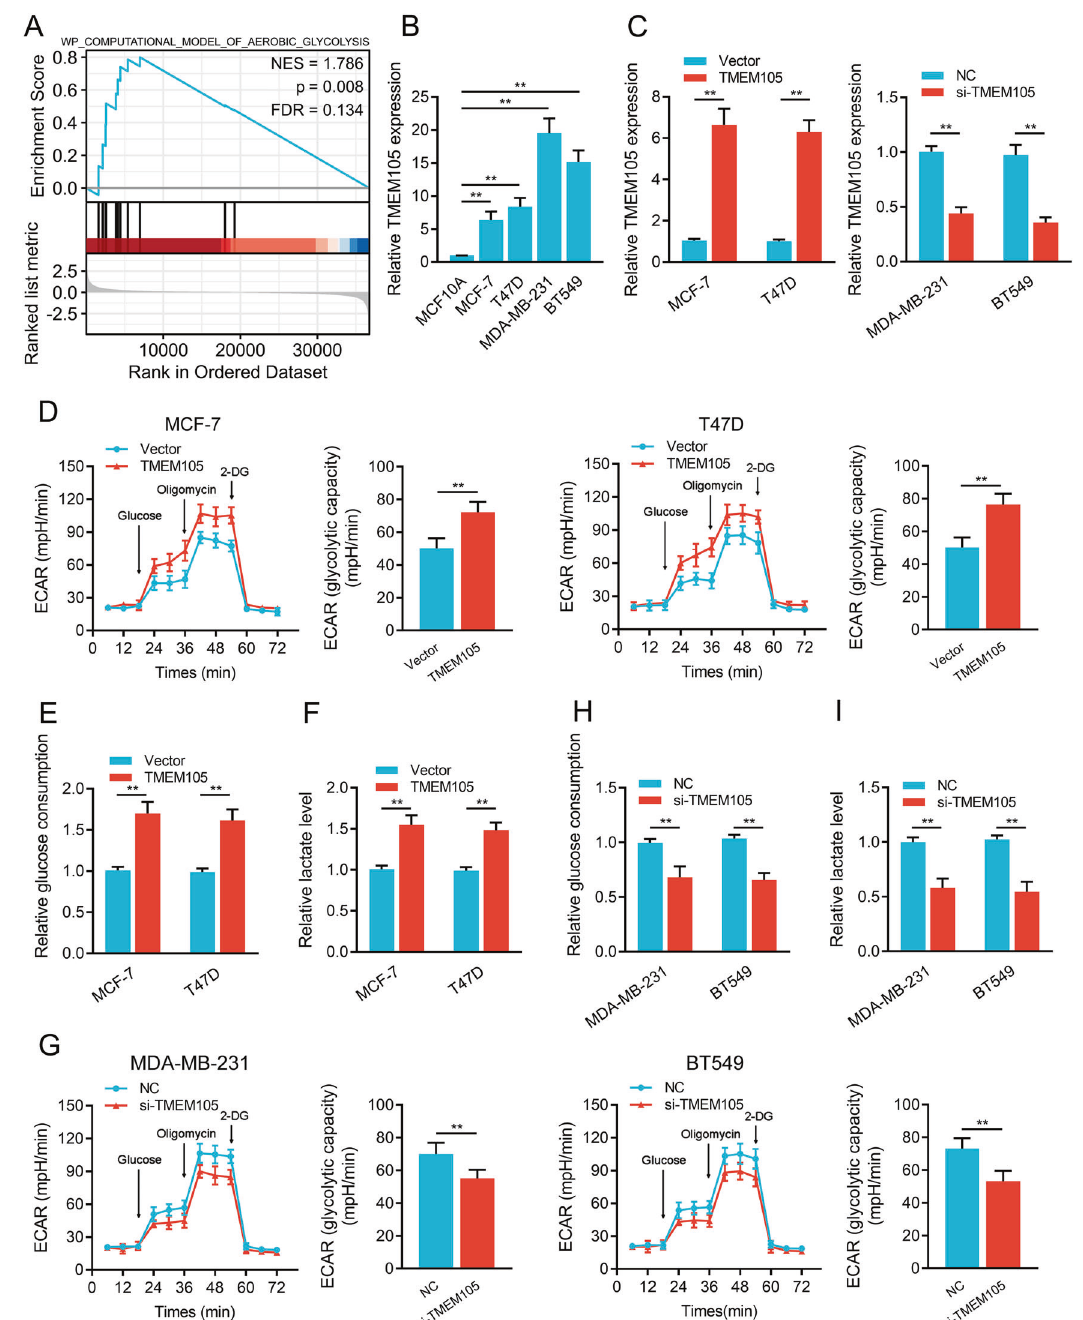
Fig. 2 TMEM105 facilitates glycolysis in breast cancer cells. A GSEA analysis showed the different gene set between TMEM105-high and TMEM105-low of breast cancer patients in the TCGA dataset. NES normalized enrichment score, FDR false discovery rate. B Expression of TMEM105 was determined by qRT-PCR in MCF10A, MCF-7, T47D, MDA-MB-231, and BT549 cells. C Effects of overexpression or knockdown of TMEM105 in breast cancer cells as shown by qRT-PCR. ECAR level ( D ), glucose consumption ( E ), and lactate production ( F ) were determined after TMEM105 overexpression in MCF-7 and T47D cells. ECAR level ( G ), glucose consumption ( H ), and lactate production ( I ) were measured after the knockdown of TMEM105 in MDA-MB-231 and BT549 cells. 2-DG 2-deoxyglucose. ** p < in the samples with high TMEM105 expression was aerobic glycolysis (FDR = 0.134, p = 0.008) (Fig. 2A), suggesting an important role of TMEM105 in the regulation of gene expression of aerobic glycolysis. Furthermore, we evaluated the expression of TMEM105 in breast cancer cells and normal breast epithelial cell MCF10A. The results showed that the TMEM105 expression in breast cancer cells was signi fi cantly higher compared to MCF10A